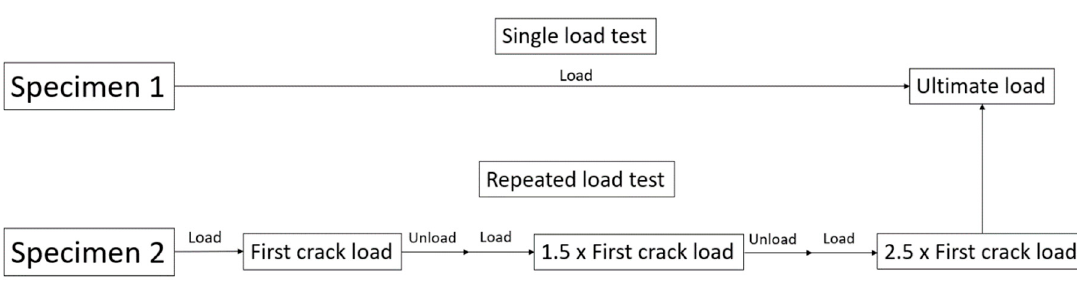
Figure 4. Testing procedure of the single load test and the repeated load test.